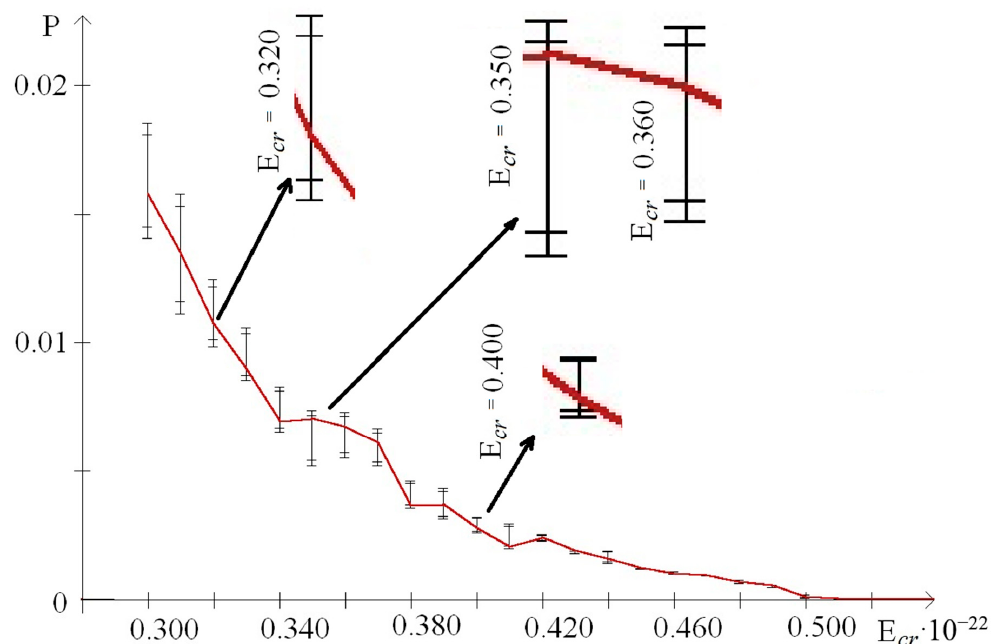
Figure 6. Dynamics of the open state (OS) occurrence in IFNA17 dependent on the H-bond dissociation energy under natural condition and after the single 2 H/ 1 H replacement (with gradation of OS occurrence frequency by decile method). Note: for each H-bond dissociation energy: the 1st cross dash is P i max , the 2nd cross dash is bottom of the 10th decile, the 3nd cross dash is top of the 1st decile; the 4th cross dash is P i min ; red line is OS occurrence frequency under condition when all hydrogen bonds in DNA are 1 H (P 0 ).